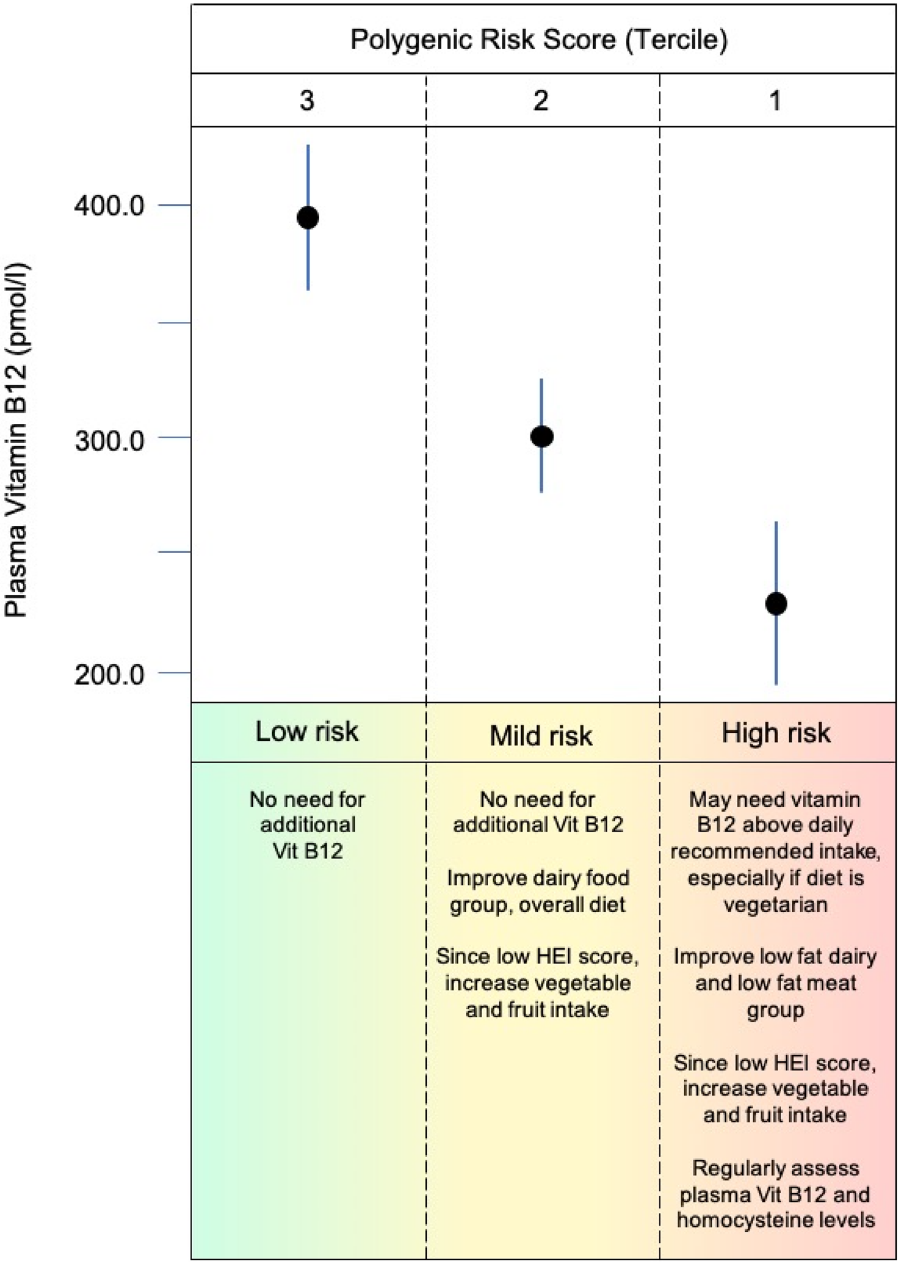
Figure 4. Hypothetical proposed nutritional counseling for vitamin B12 intake based on PRS terciles, nutritional and demographic